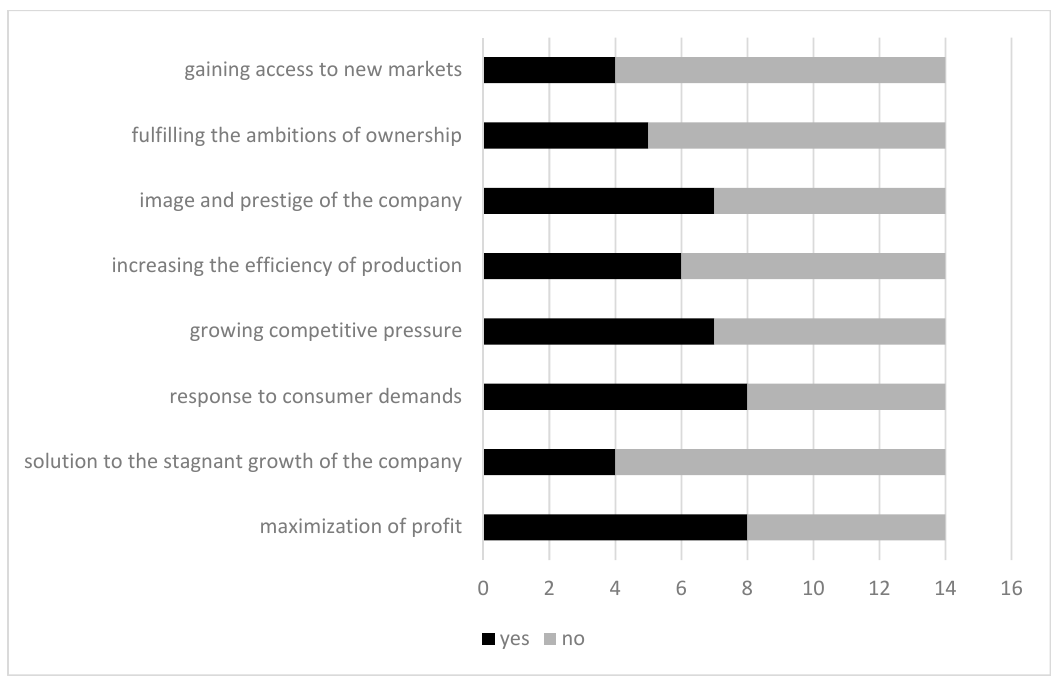
Figure 4. Motives for innovation declared by knowledge intensive ventures in the sample.